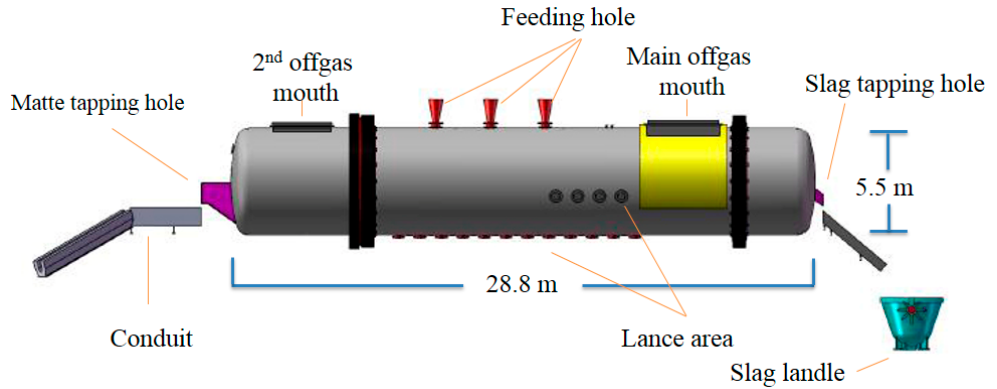
Figure 1. Schematic diagram of an SKS (Shuikoushan) smelting furnace.